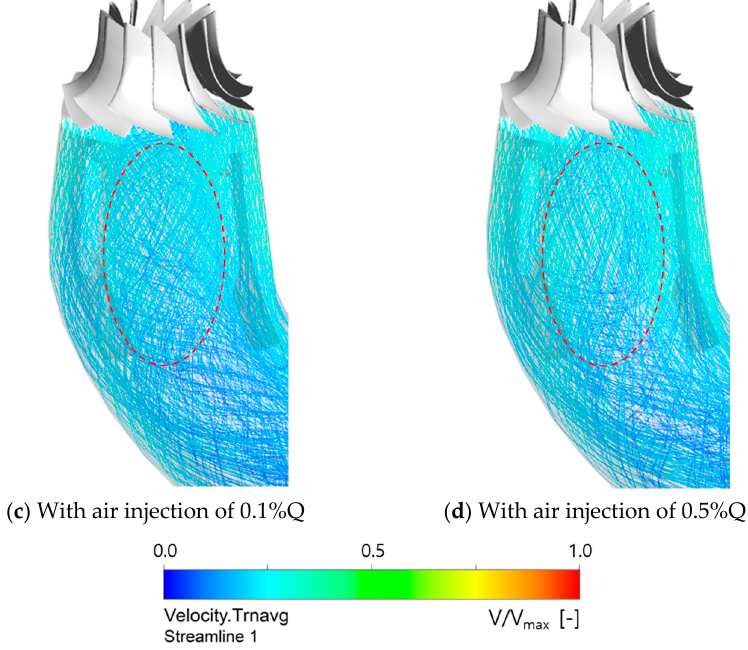
Figure 8. Streamline distributions with velocity—Trnavg in the DT with and without air injection and anti-swirl fins.